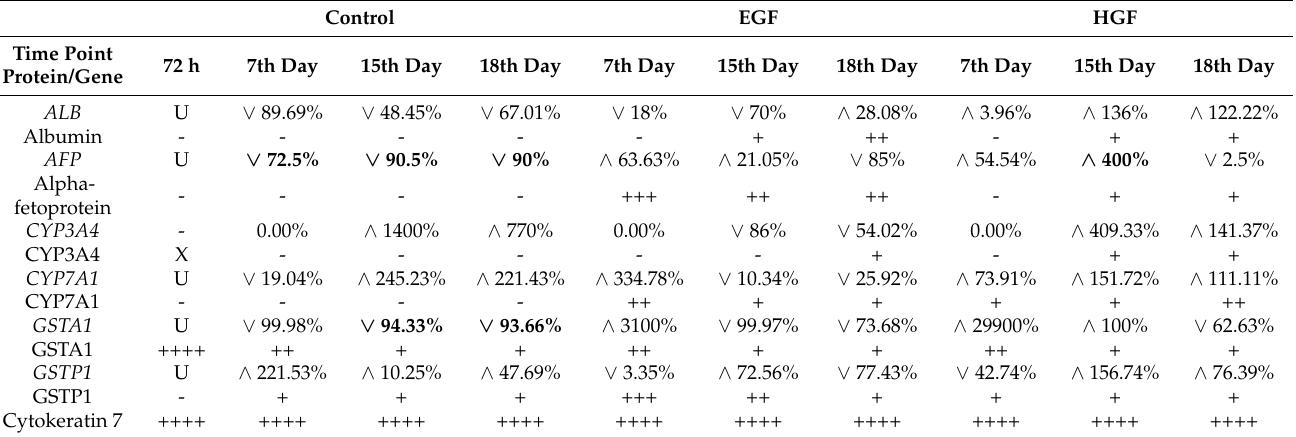
Table 6. Phenotypic characterisation of hAECs in control culture (C) and differentiating cultures (EGF, HGF) based on the percentage change in gene expression and the number of cells expressing the relevant proteins—markers of hepatoblasts, hepatocytes, and cholangiocytes. EGF